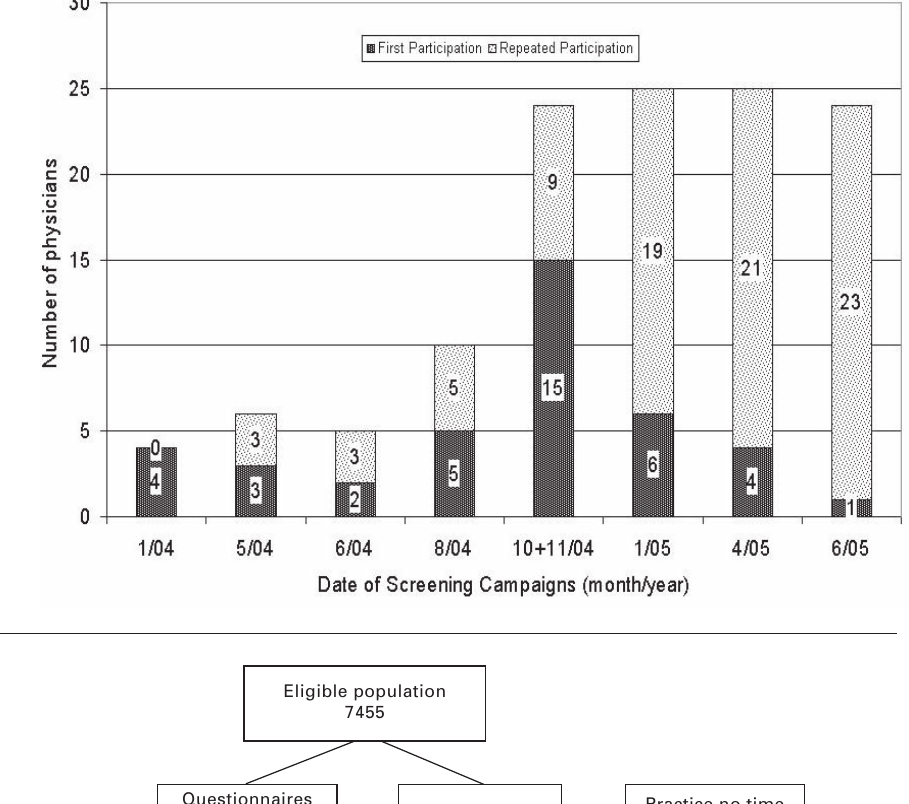
Figure 3 Implementation of project in medical